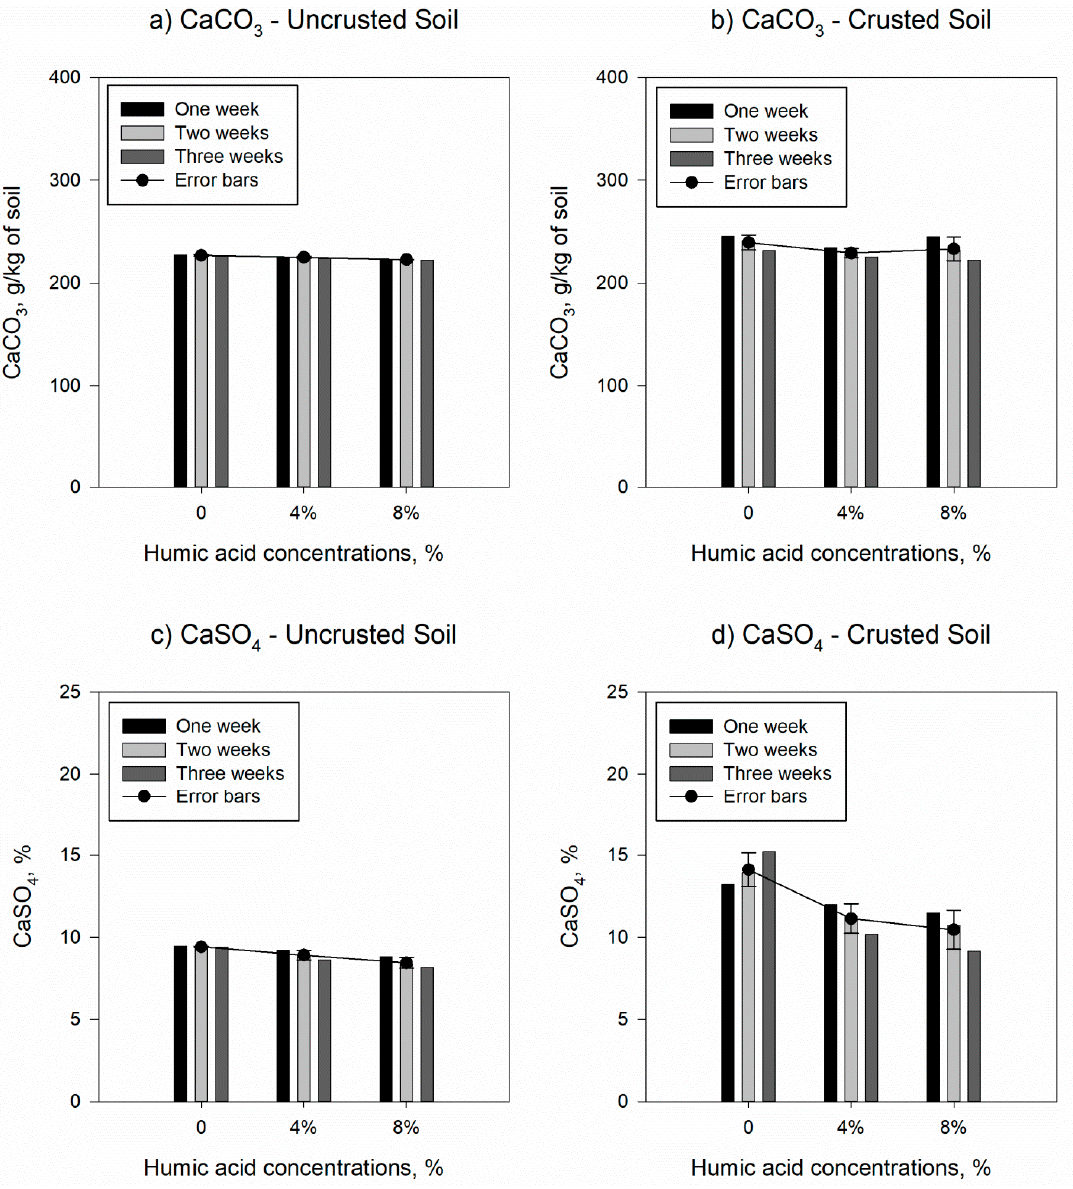
Figure 8. Influence of humic acid concentrations of 0%, 4%, and 8% on: ( a ) CaCO 3 of uncrusted soils, ( b ) CaCO 3 of crusted soils, ( c ) CaSO 4 of uncrusted soils, and ( d ) CaSO 4 of crusted soils at different curing times. The error bars are the standard deviations from the mean values of different curing times for each HA concentration.